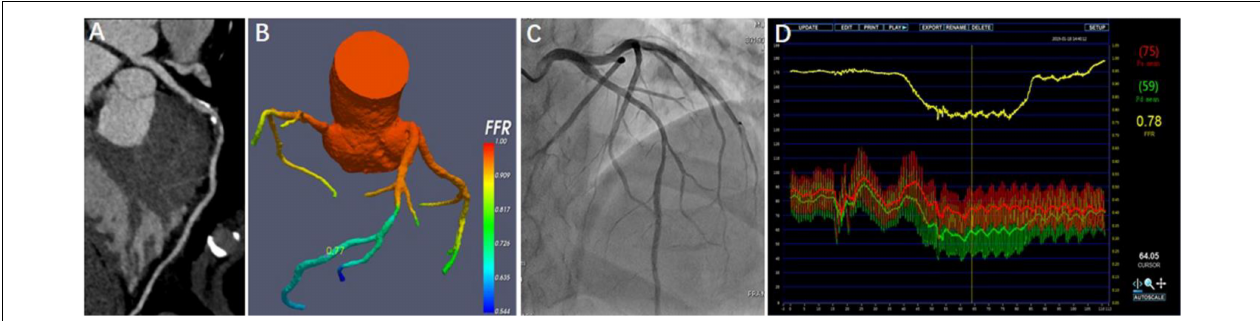
FIGURE 4 | Representative case from the study. A 45-year-old man with atypical angina. CTA showed a 50–70% stenosis in the middle segment of the left anterior descending artery (LAD) (A) , and CT-FFR value (0.77) was measured in the distal of target lesion (B) . Invasive coronary angiography (ICA) demonstrated the severe stenosis of 70% (C) . FFR measured at the corresponding location was 0.78 (D)